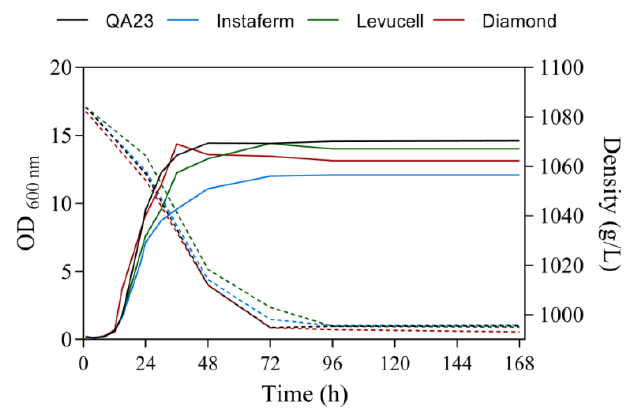
Figure 1. Fermentation kinetics of the different Saccharomyces yeast strains by monitoring the density of the must (dotted line) and yeast population, measured as optical density at 600 nm (OD 600 , solid line) throughout the fermentation.